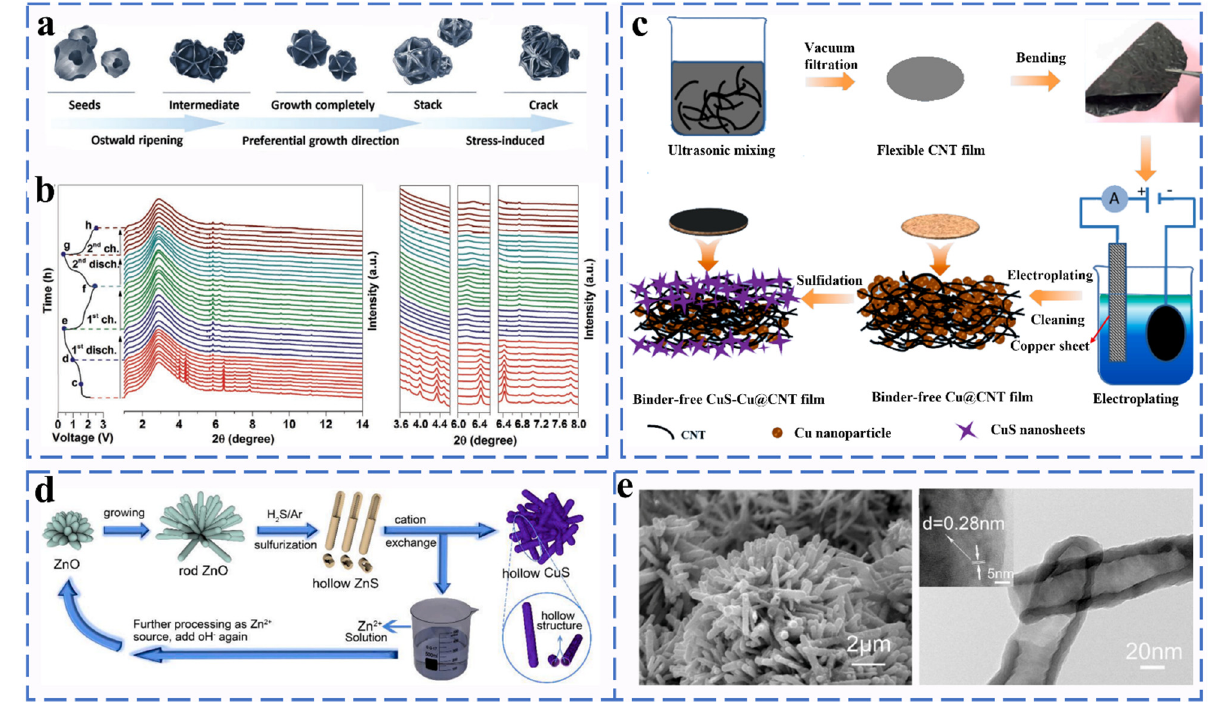
Figure 9. ( a ) Schematic illustration of the formation mechanism of CuS spheres. ( b ) In situ SRD patterns of CuS electrode collected at first and second cycle charge–discharge processes between 0.4 and 2.6 V. Diffraction peak changes at various 2 theta degrees at first and second cycle charge–discharge states. Reprinted with permission from Ref. [63]. Copyright 2018 copyright. Ge, P. ( c ) Schematic of the fabrication process for the CuS-Cu@CNTs membrane. Reprinted with permission from Ref. [64]. Copyright 2018 copyright. Jeong. S. ( d ) SEM image of zinc oxide prepared by reacting at 60 °C for 4 h. ( e ) SEM and TEM image for the preparation of zinc oxide at 60 °C for 8 h. Reprinted with permission from Ref. [65]. Copyright 2018 copyright. Zhao, X.